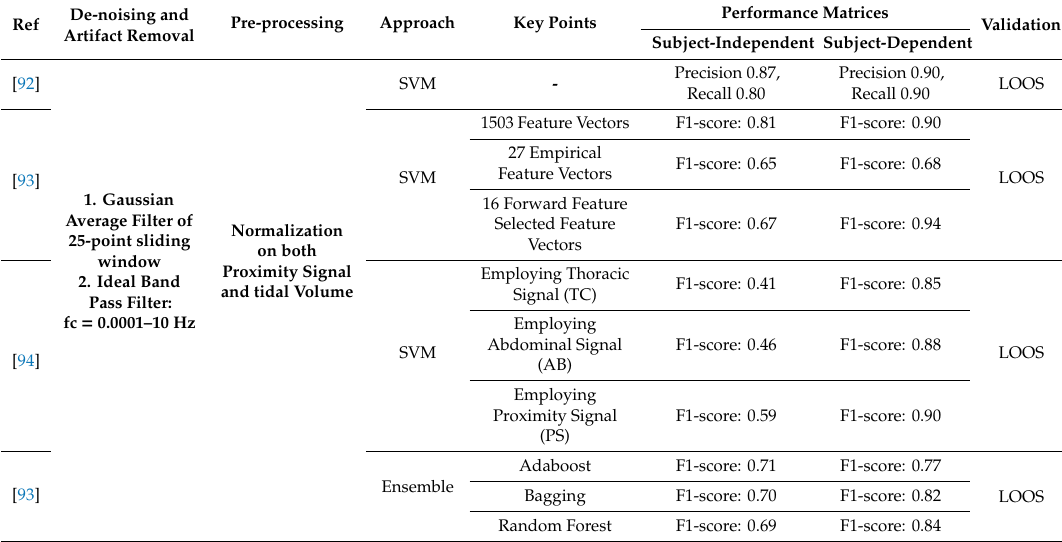
Table 14. Summary of detection algorithms employed on the combination of respiration and proximity